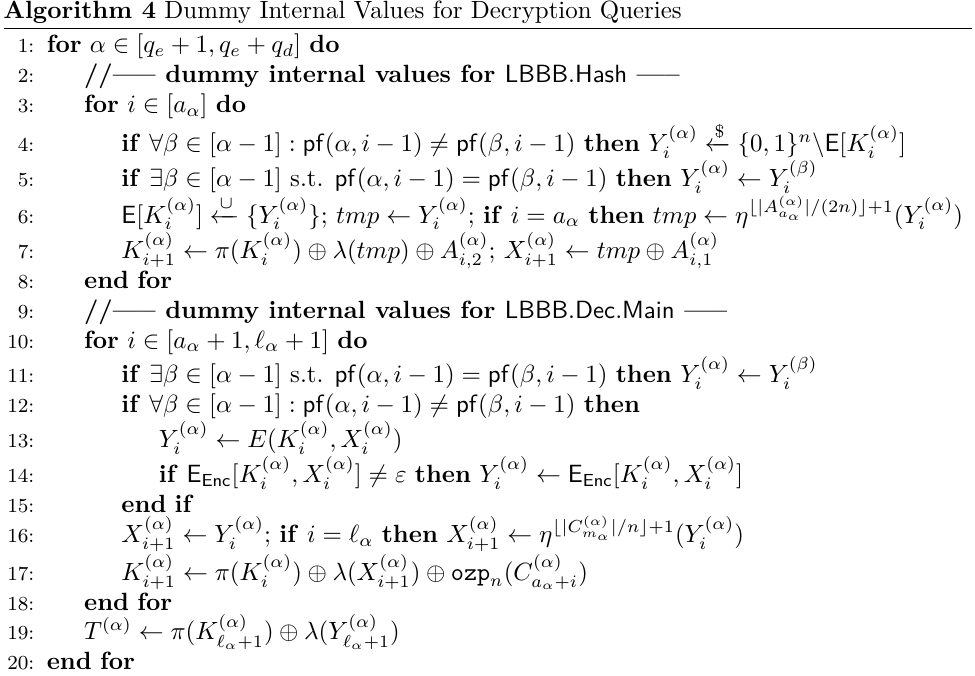
Algorithm 4 Dummy Internal Values for Decryption